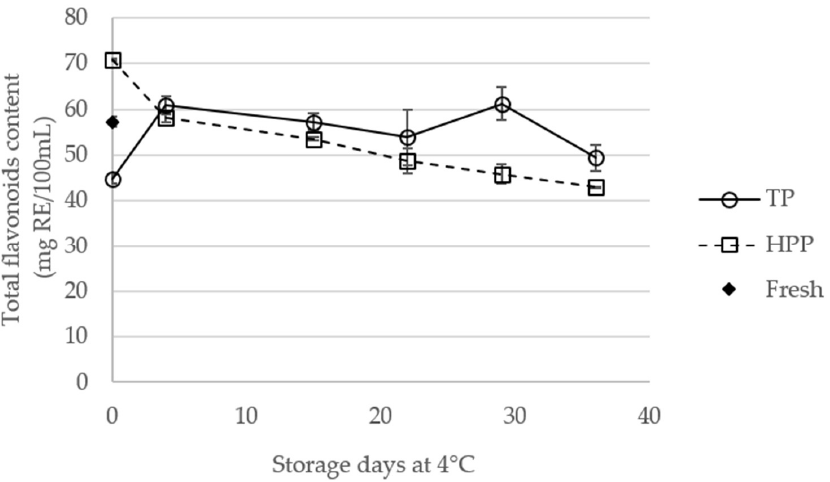
Figure 2. Total flavonoid content (expressed as rutin equivalents (RE)) of fresh and thermal pasteurized (TP) and high-pressure processed (HPP) orange juices during storage at 4 °C.